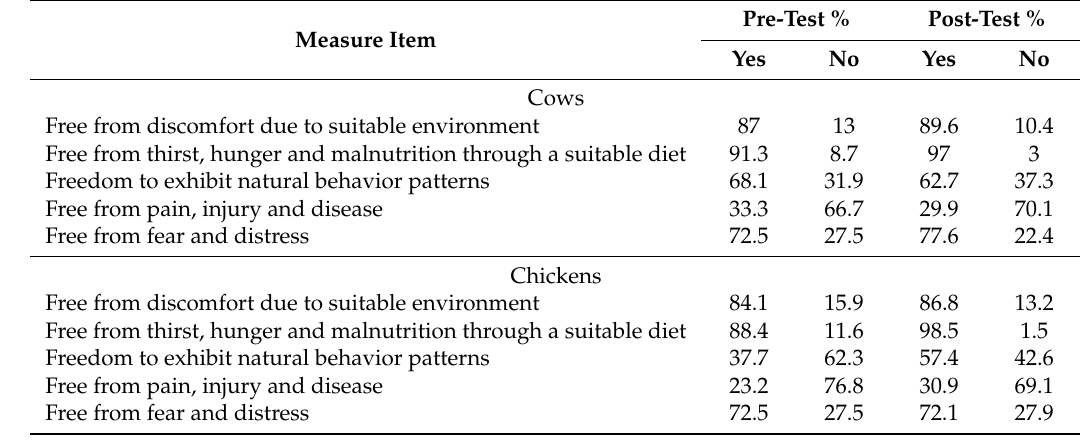
Table 6. Descriptive statistics for knowledge about the five freedoms for animals, displaying the percentage of children in the intervention group who mentioned each freedom.